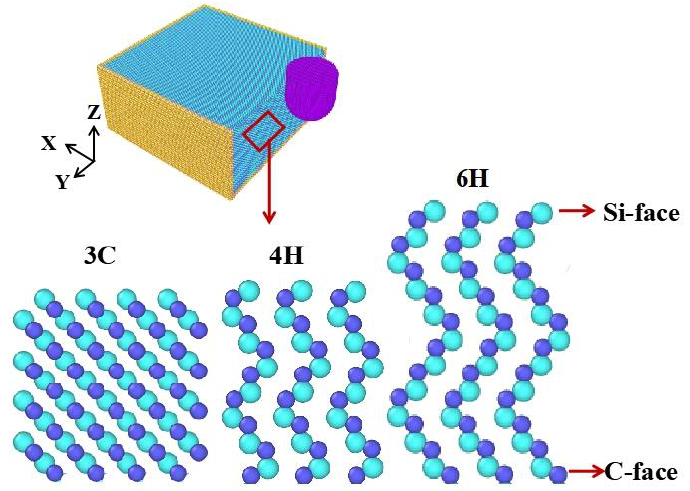
Figure 1. Molecular dynamics model of 3C-, 4H- and 6H-SiC.